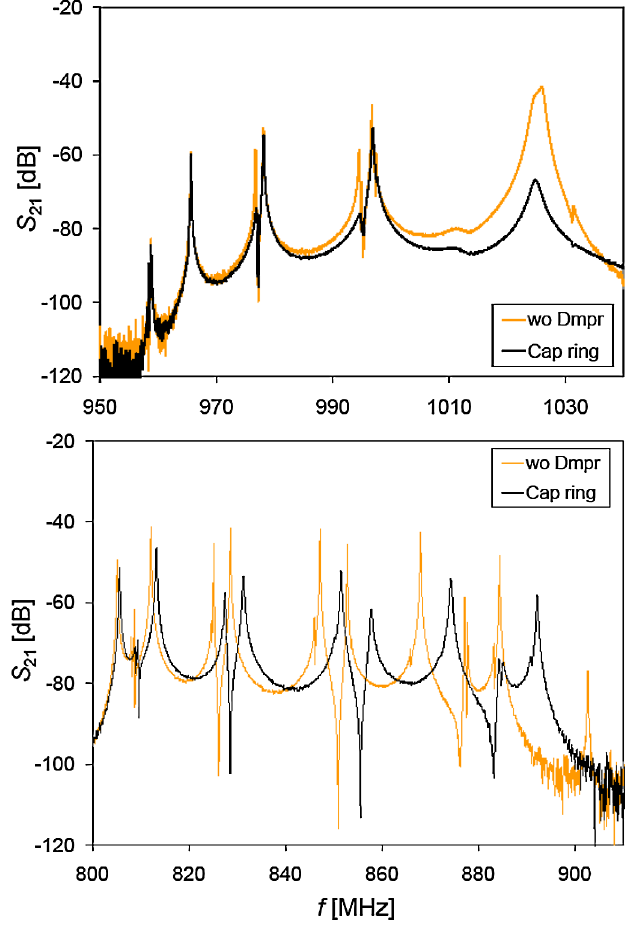
FIG. 21. Frequency spectrum of a capacitive damper ring with staggered dampers between Cu